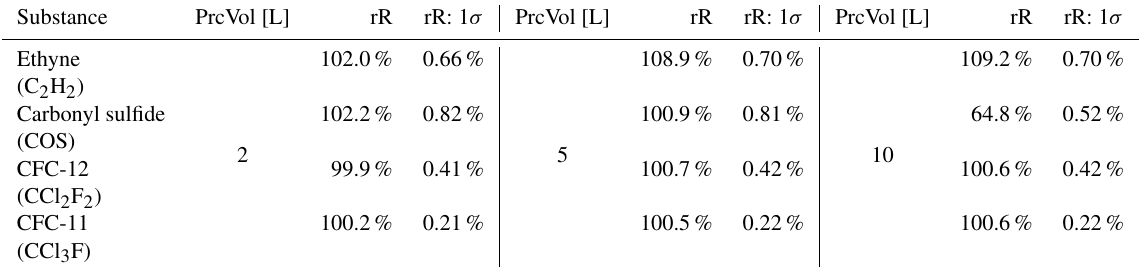
Table 3. Results from a volume variation experiment, comprising measurements of the same reference air with preconcentration volumes (PrcVol) of up to 2, 5 and 10L. Laboratory set-up using adsorptive material Unibeads 1S. Volume-corrected detector response is referenced against calibration preconcentration volumes of 1L (rR). rR<100% indicates underestimation (e.g. loss by breakthrough); rR>100% indi- cates overestimation (e.g. increase by a memory effect from the preceding sample or contamination). Breakthrough is observed for COS at a preconcentration volume of 10L while ethyne shows signs of a system contamination (rR>100% despite a higher volatility compared to COS). CFC-12 and CFC-11 show no indication of breakthrough, with all deviations from 100% rR below 3 σ